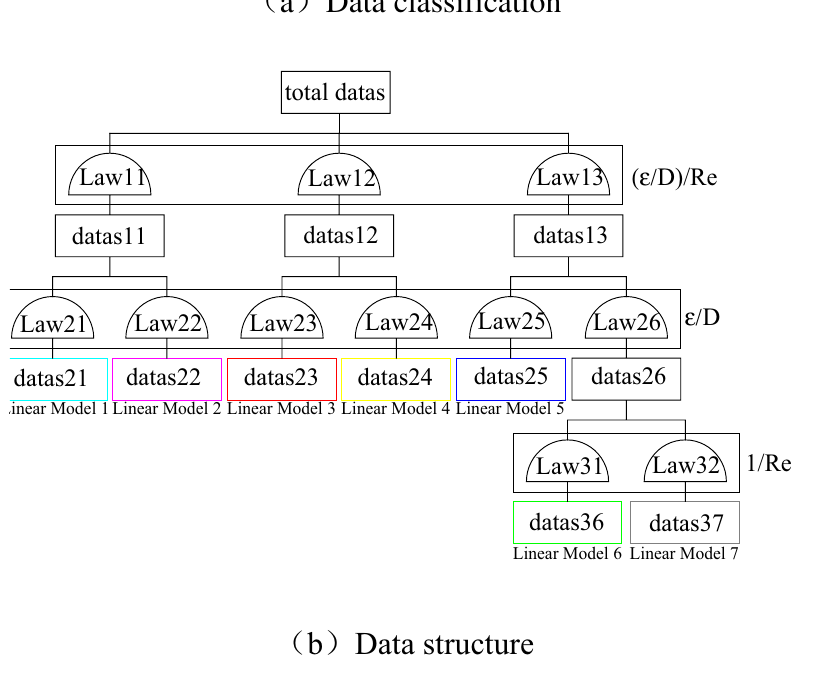
Figure 5. Model tree